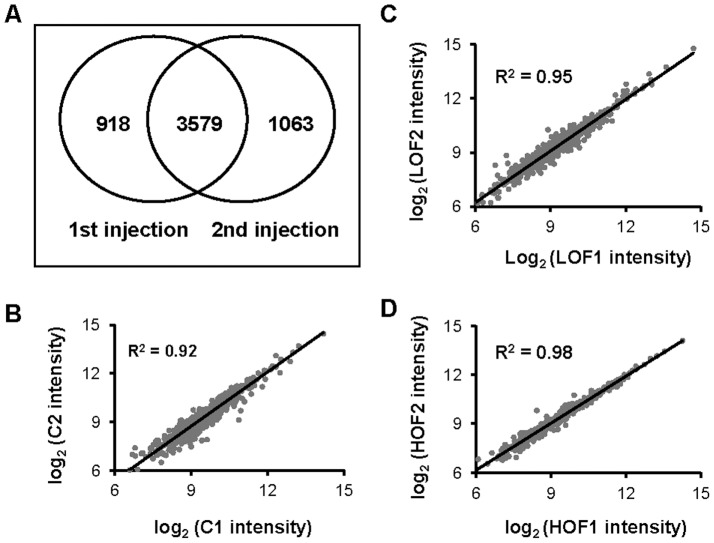
Quality control for the qualitative and quantitative data generated by mass spectrometry.(A) The overlap rate of the unique peptides identified in replicate injections. (B to D) Correlation analysis of the quantitative signals in the biological replicates was performed using the Pearson method. The log2 values of the normalized tag intensities of the proteins in one sample are plotted against those of the parallel sample. The squares of the correlation coefficients (R2) and the slope of the regression curve are listed in the insert. B: Control; C: LOF; and D: HOF.